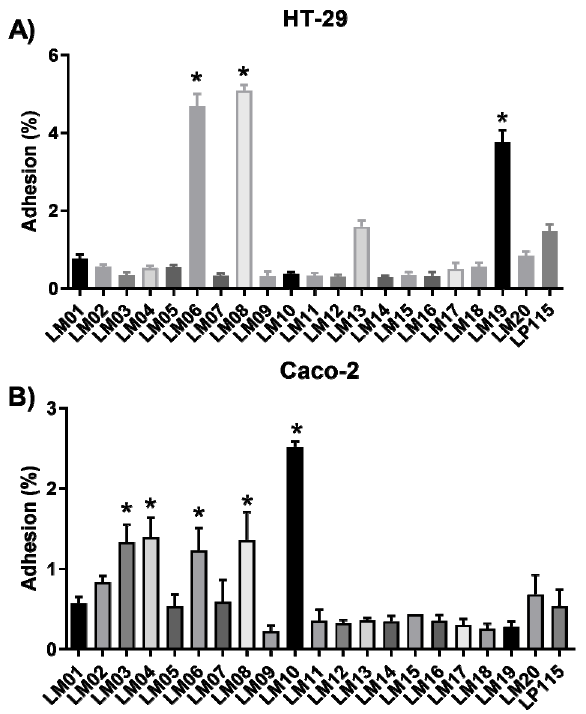
Figure 2. In vitro adhesion of lactic acid bacteria (LAB) isolated from agave to HT-29 ( A ) and Caco-2 cells ( B ). Results are the mean ± SEM from three independent experiments. * Indicates a significant difference as compared to L. plantarum Lp115 ( p <